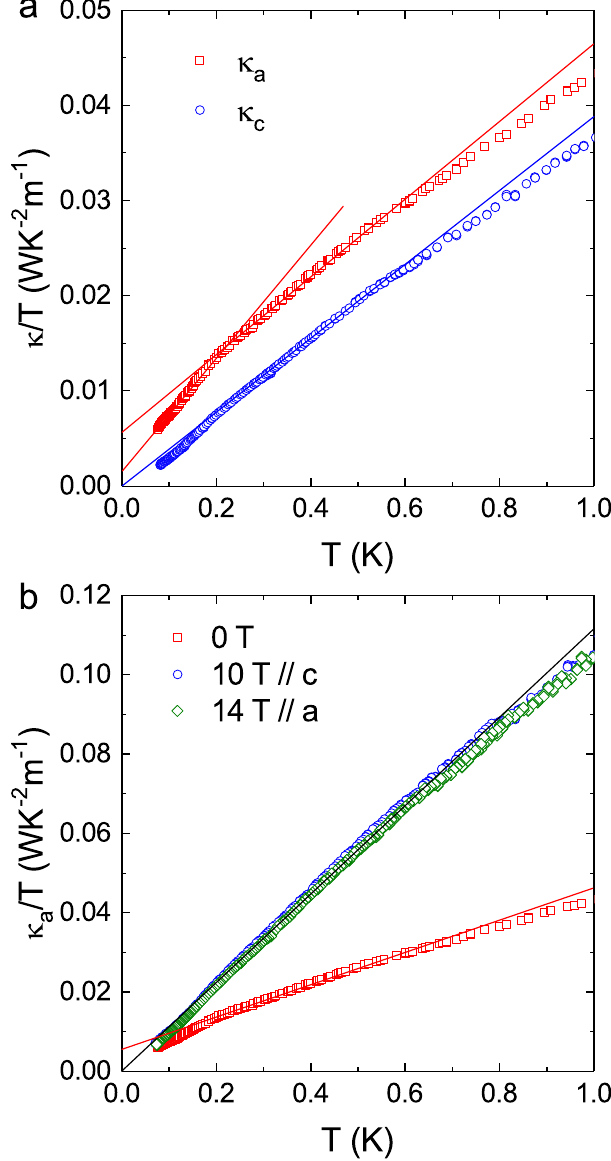
Fig. 1 Ultralow-temperature thermal conductivity of YbMgGaO4 single crystals. a Data measured along the a -axis ( κ a ) and the c- axis ( κ c ), plotted as κ / T vs. T 2 . The solid lines are some linear fi tting results. The κ c display a T 2 behavior at T < 600 mK with zero intercepts at T = 0. The κ T 2 at 200 mK < T < 600 mK with a residual thermal conductivity of κ 0.0058 W K − 2 m − 1 and a smaller κ 0 / T = 0.0016 W K − 2 m − 1 at T < 200 mK. b The a -axis thermal conductivity in zero fi eld and in 10 T (14 T) magnetic fi eld applied along the a - (the c- ) axis. The high- fi eld κ c data display a T 2 behavior at T < 700 mK with κ 0 / T =